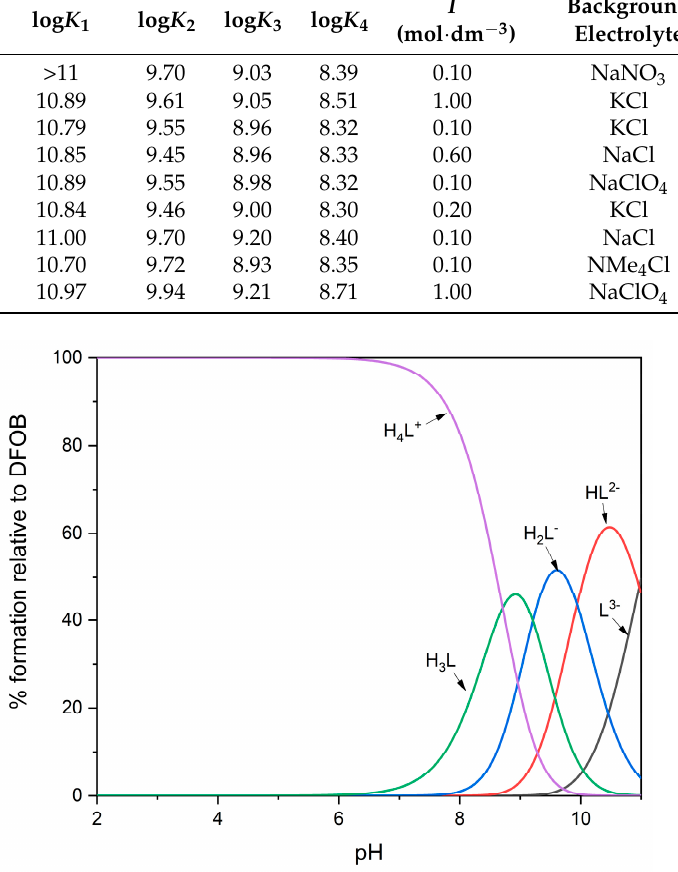
Figure 1. Representative distribution diagram for protonation equilibria of DFOB, at 25 °C and I = 1.0 mol·dm − 3 (NaClO 4 )